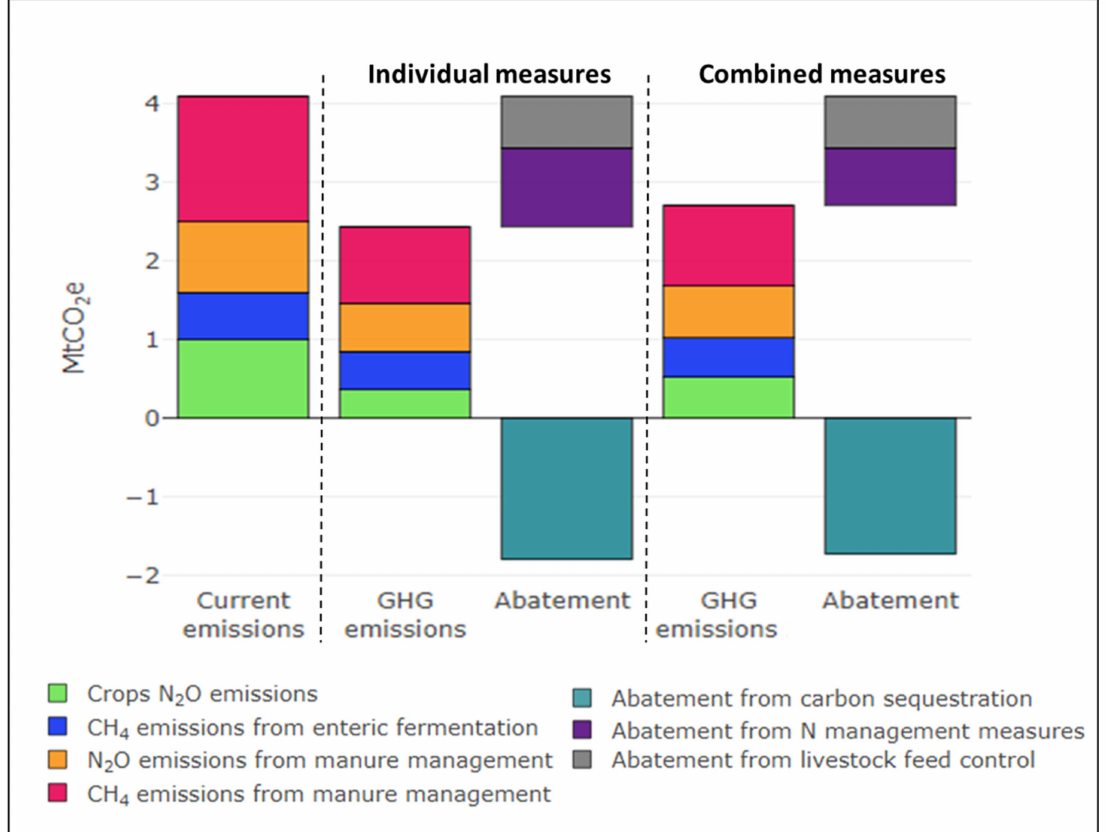
Figure 3. Agricultural GHG emissions and abatement under individual and combined measures. Individual measures are measures evaluated separately without considering interactions, and combined measures are evaluated taking into account their